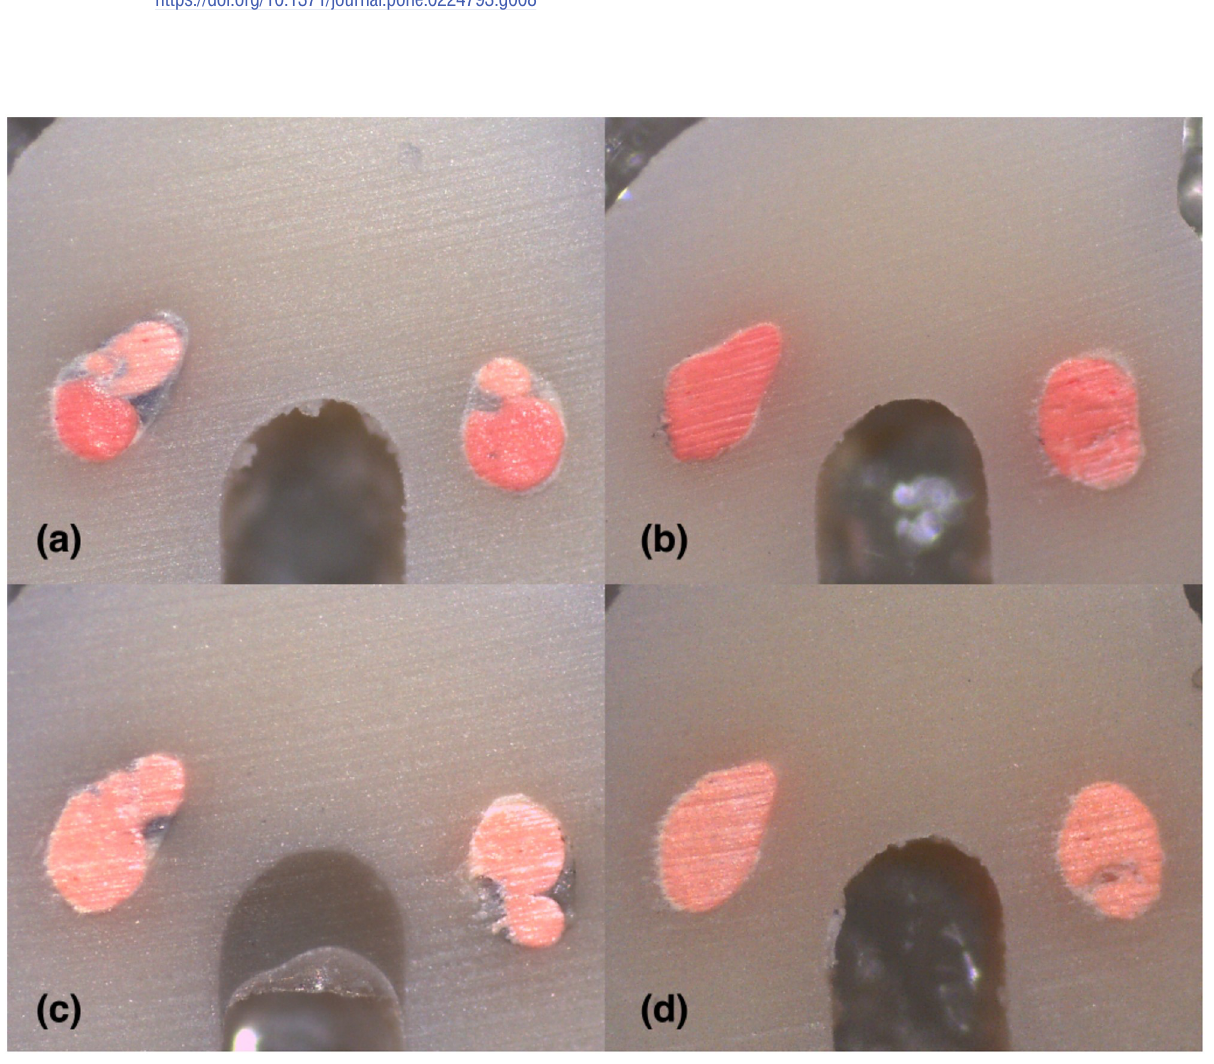
Fig 9. Stereomicroscope images of 2 mm sections instrumented with Hyflex EDM: (A) LC (B) CW; Stereomicroscope images of 2 mm sections instrumented with Reciproc Blue: (C) LC (D) CW in C2-type.